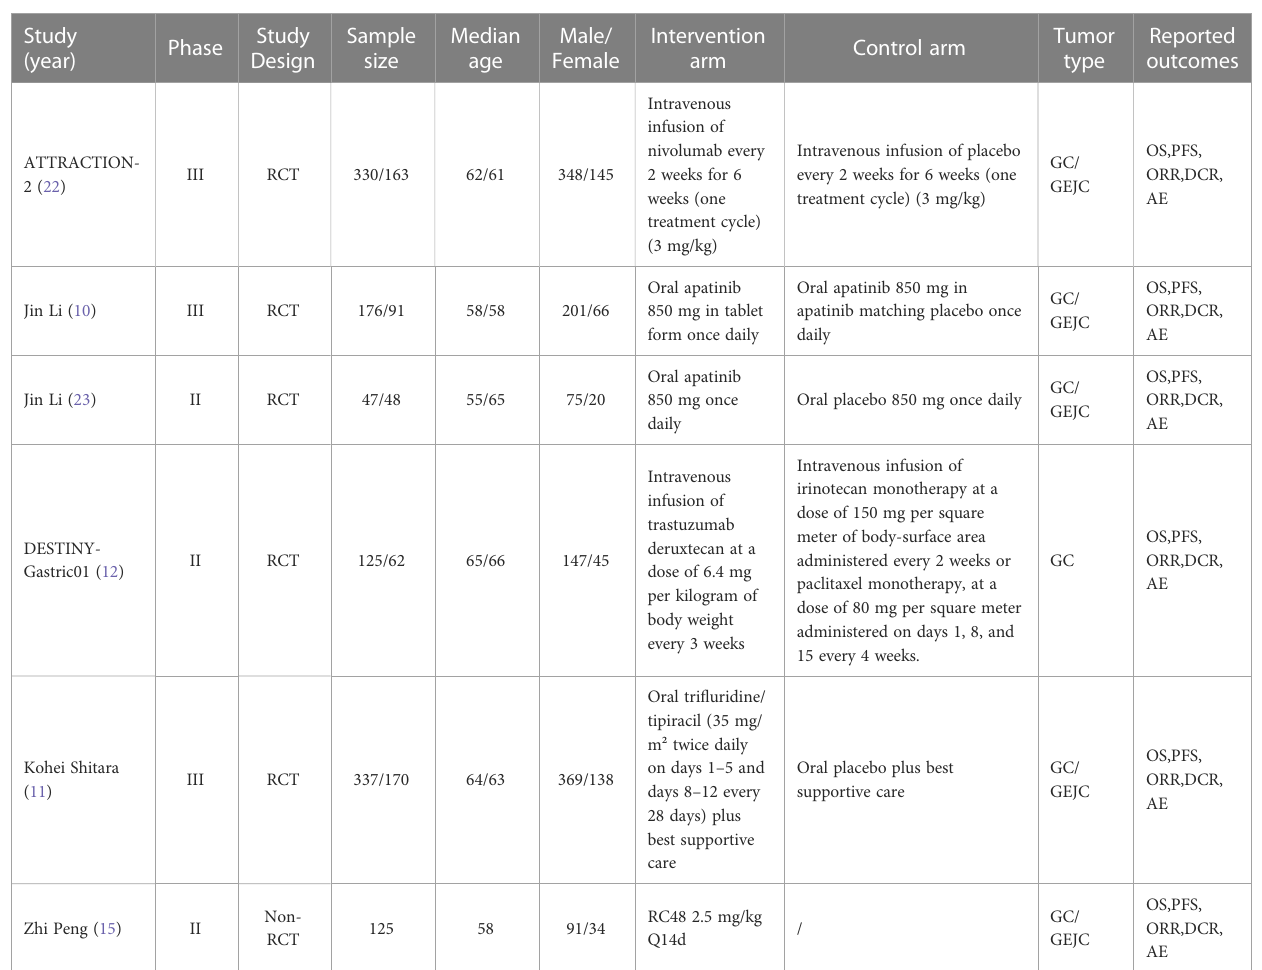
TABLE 1 Baseline characteristics of studies included in the systematic review with Bayesian network meta-analysis of third-line treatments for advanced gastric